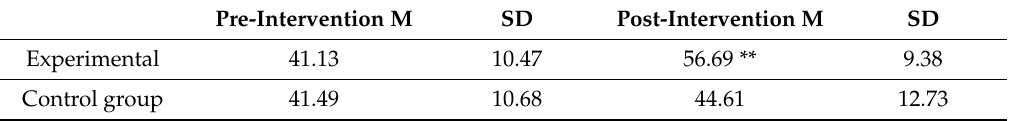
Table 1. Pre–post e-safety performance for experimental and control group.